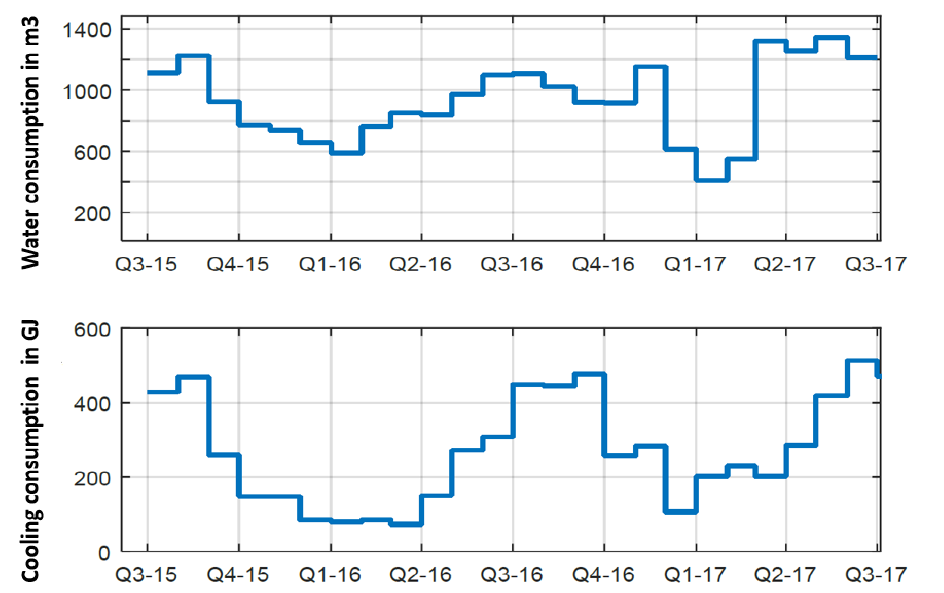
Figure 5: Consumption of water by months in comparison with monthly cooling consumption. (Source: authors with the use of